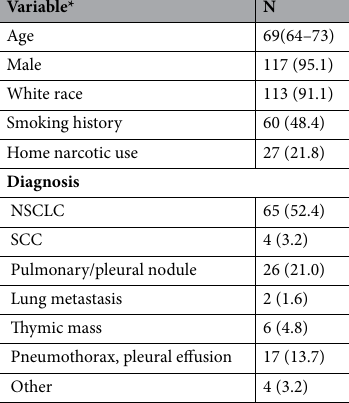
Table 2. Demographics for 124 patients undergoing thoracic surgery. NSCLC non-small cell lung cancer, SCC small cell carcinoma. *Data are reported as numbers (percentiles) and medians (interquartile